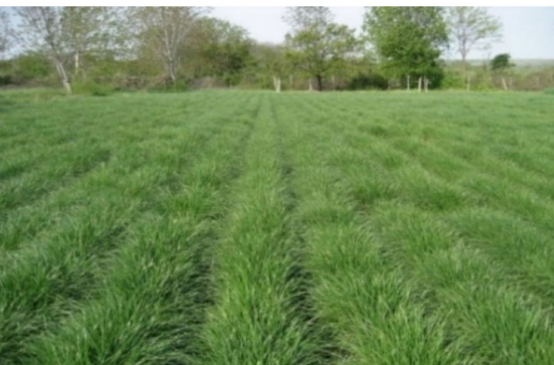
Figure 4. Perennial ryegrass ( Lolium perenne L.) Variety IFC Harmoniya. Author’s photos of Prof. A. Katova.